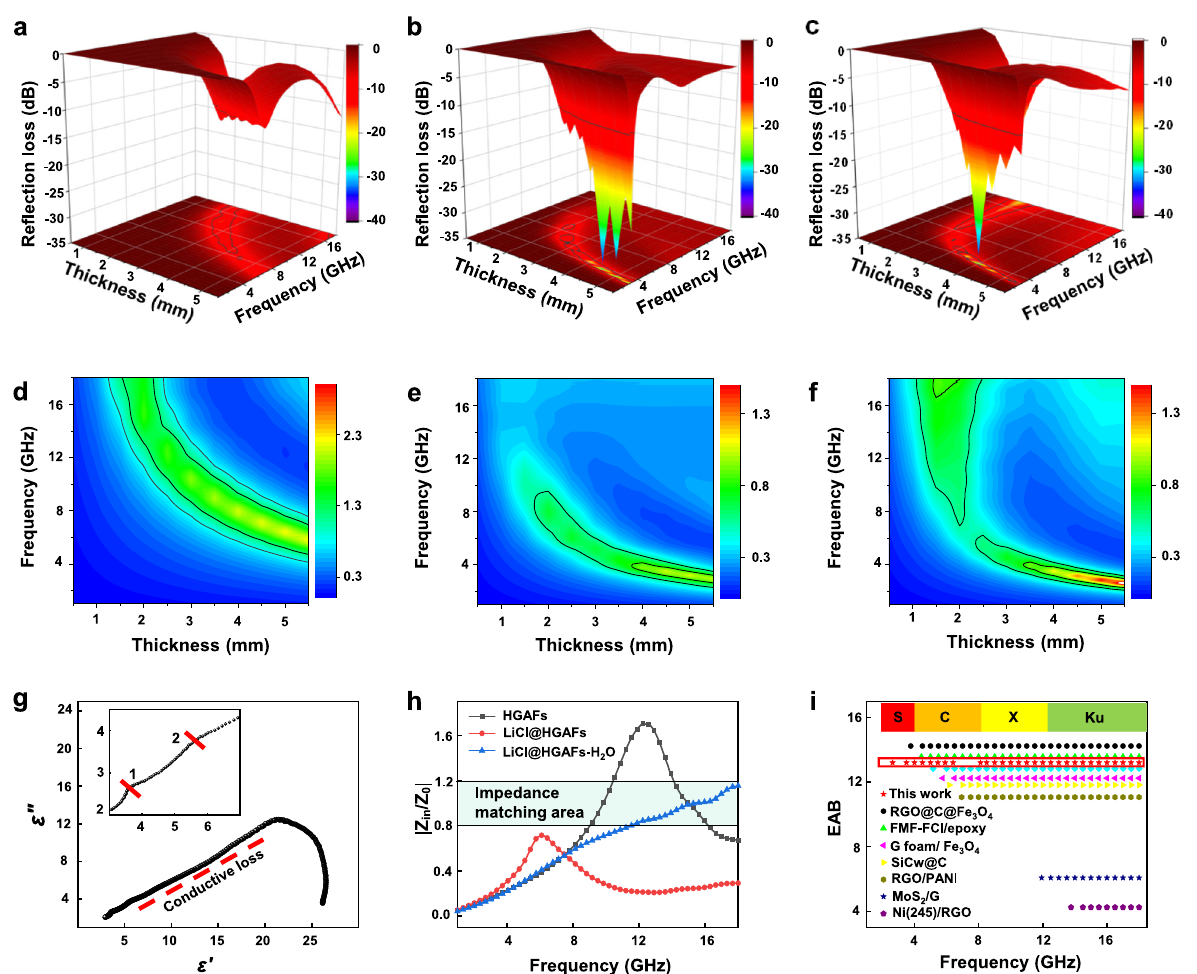
Fig. 7 Microwave absorption characterization. Re fl ection loss (RL) value of a HGAFs, b LiCl@HGAFs, and c LiCl@HGAFs-H 2 O. Source data are provided as a Source Data fi le. Calculated |Z in /Z 0 | values of d HGAFs, e LiCl@HGAFs, and f LiCl@HGAFs-H 2 O at different thicknesses. Source data are provided as a Source Data fi le. g Cole-cole plot of LiCl@HGAFs-H 2 O. Source data are provided as a Source Data fi le. h The |Z in /Z 0 | value of HGAFs, LiCl@HGAFs, and LiCl@HGAFs-H 2 O with a thickness of 2.5 mm. Source data are provided as a Source Data fi le. i The integrated effective absorption bandwidth (EAB) at the scope of 1 – 18 GHz. The S, C, X, and Ku in panel ( i ) refer to different microwave bands, 2 – 4 GHz, 4 – 8 GHz, 8 – 12 GHz, and 12 – 18 GHz, respectively. Source data are provided as a Source Data fi le.